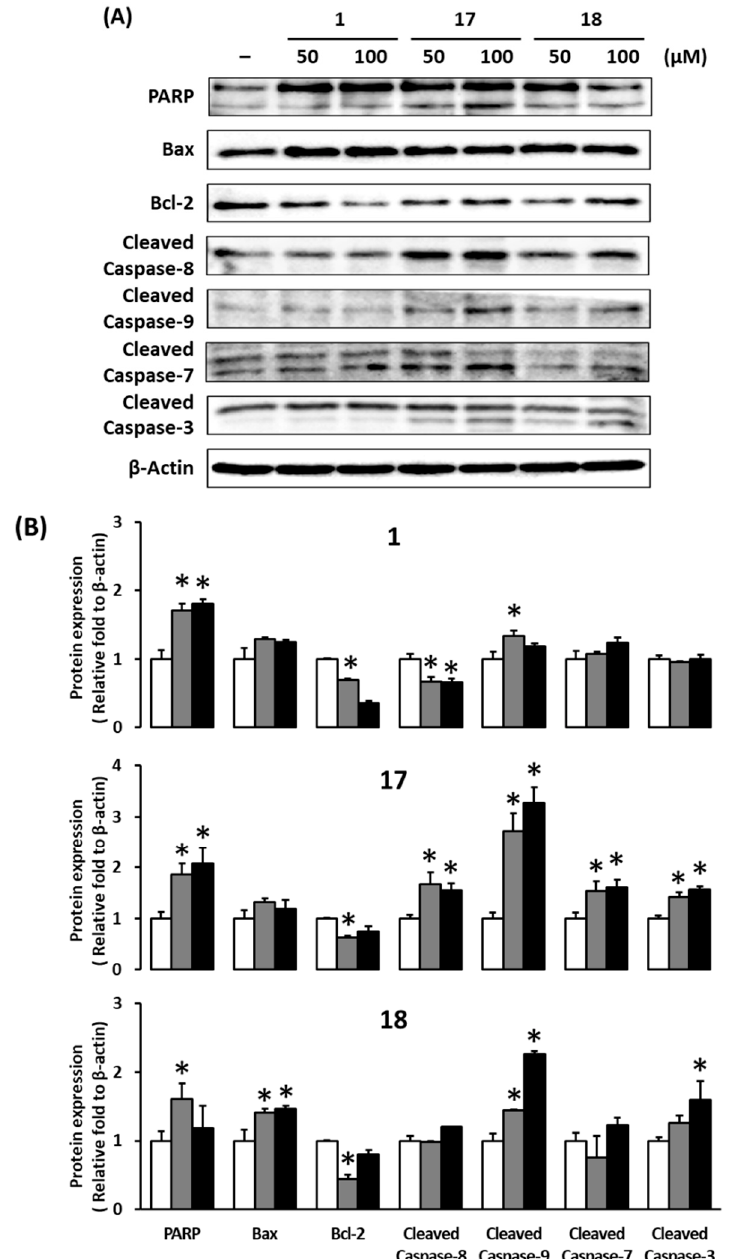
Figure 5. Effects of gallic acid ( 1 ), decursin ( 17 ), and decursinol angelate ( 18 ) on apoptosis in MCF-7 cells exposed to 50 and 100 µ M for 24 h, determined by western blotting. ( A ) Protein expression of poly (ADP-ribose) polymerase (PARP), Bcl-2-associated X protein (Bax), B-cell lymphoma 2 (Bcl-2), cleaved caspase-8, -9, -7, -3, and β -actin; ( B ). Graph of relative protein expression. The data are presented as the mean ± S.D. and were analyzed using a one-way analysis of variance (ANOVA) and a Dunnett’s multiple comparisons post hoc analysis. * p < 0.05 versus untreated cells.